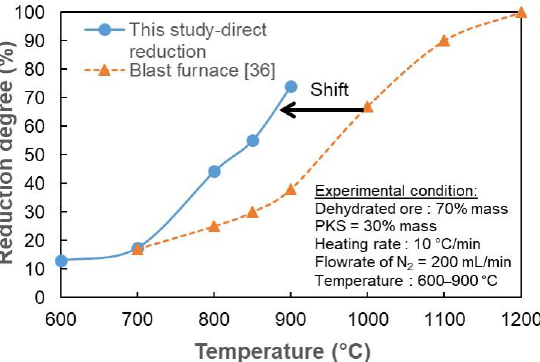
Figure 11. Reduction degree of the iron ore-biomass pellets by a direct reduction process at different temperatures compared to the blast furnace process.